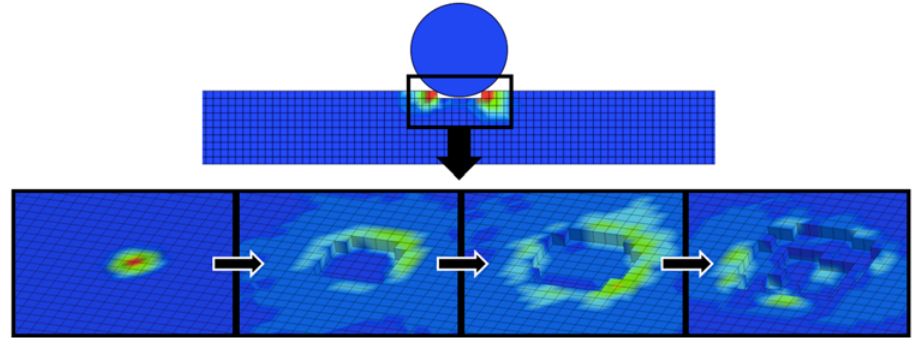
Figure 16. Evolution of damage caused by the impactor in the form of an indentation on a 1 mm square mesh showed through a von Mises stress gradient.